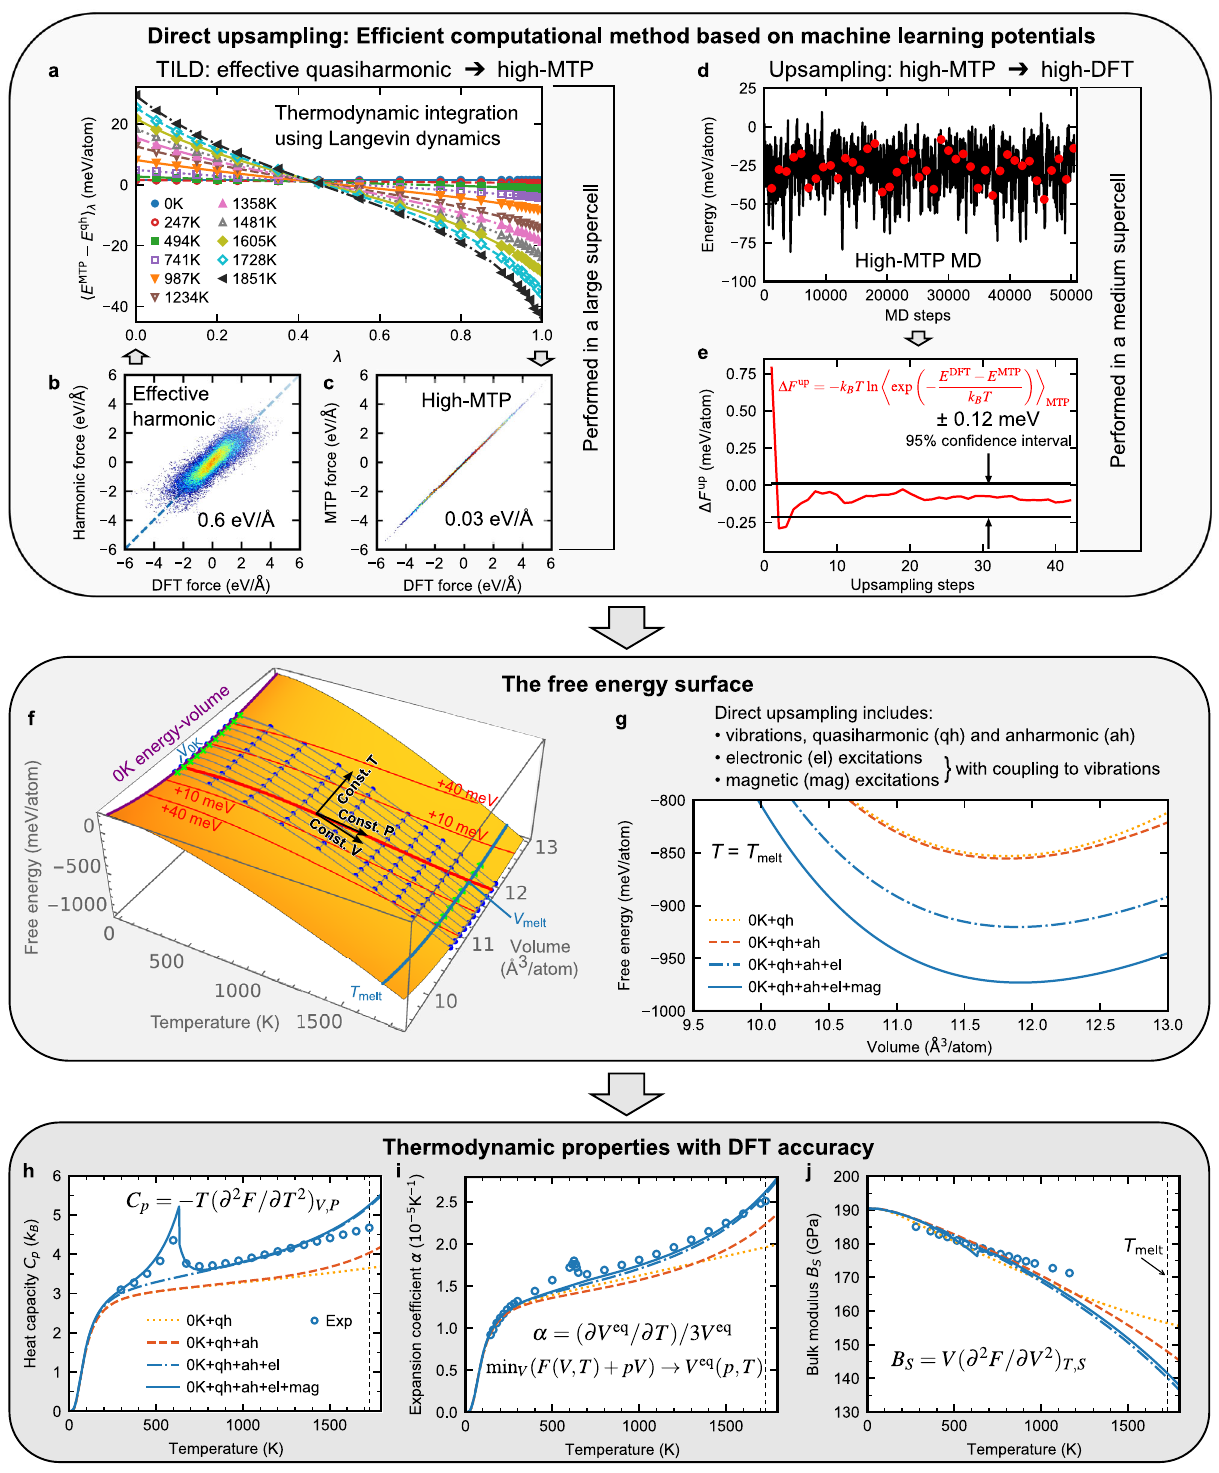
Fig. 1 Schematic description of the entire work fl ow using fcc Ni as an example. The upper box illustrates different stages of direct upsampling: a TILD at different temperatures from effective QH to MTP (whose force RMSEs are shown in ( b , c )), and d , e the upsampling to high-DFT. The center box is the crux of the work fl ow. f is a representation of the free-energy surface, with the ( V , T ) mesh on which free-energy calculations are performed represented by blue dots, volumes at T melt chosen for MTP training set represented by green dots, volumes for the low-temperature effective QH fi tting represented by green crosses, the 0 K E – V curve in purple and different derivatives represented by black arrows. g is the free energy as a function of volume at the melting point calculated while including different excitations. The lower box shows the numerically computed ( h ) isobaric heat capacity C p , i linear thermal expansion coef fi cient α and j adiabatic bulk modulus B S along with a comparison to experimentally calculated values 41,51,52 . ( V eq = V eq ( T ) denotes the equilibrium volume at T and a given pressure, V 0K = V eq (0 K) and V melt = V eq ( T melt ), where T melt is the experimental melting temperature at ambient pressure; S is the